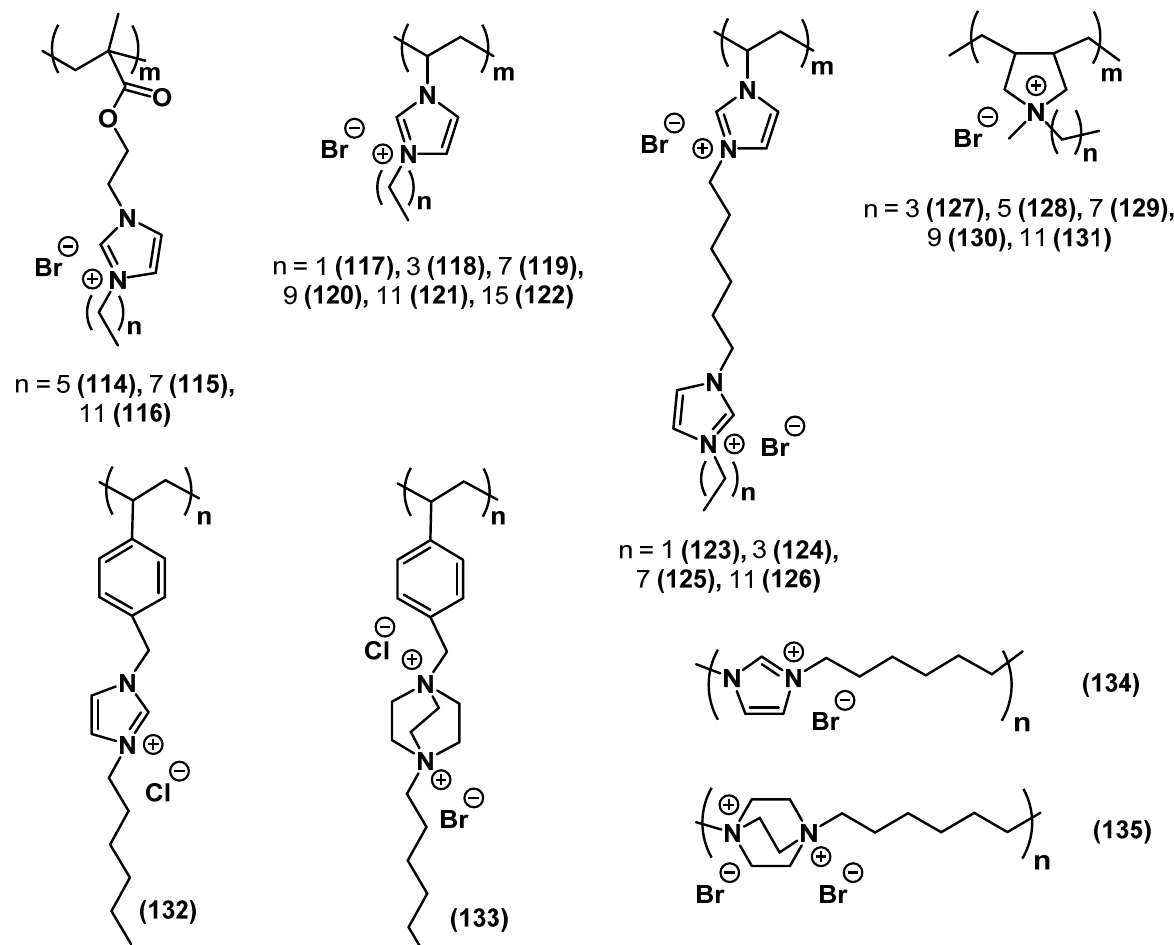
Figure 35. Examples of poly-ILs with tested antimicrobial activity. The numbers of substances correspond to those in Table 8. Table 8. Antimicrobial activity of poly-ILs * .